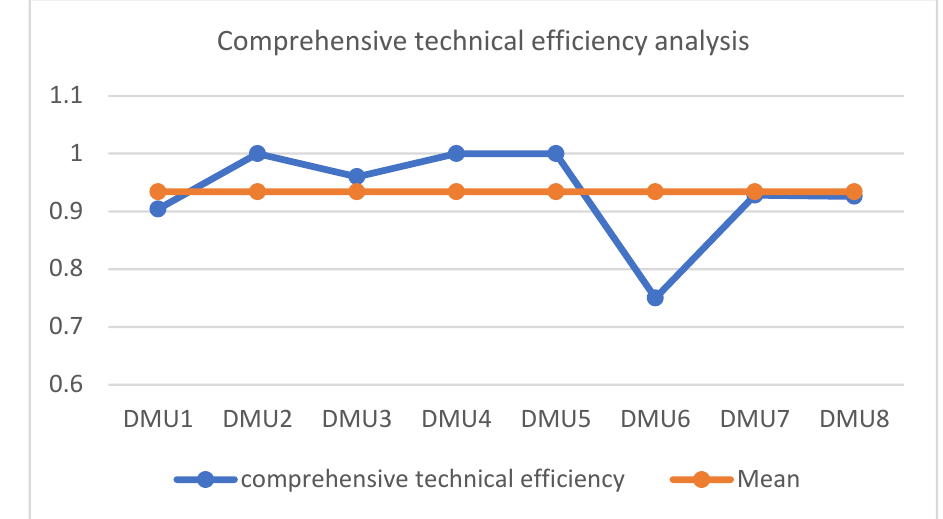
Figure 2. Comparative analysis of comprehensive technical efficiency.